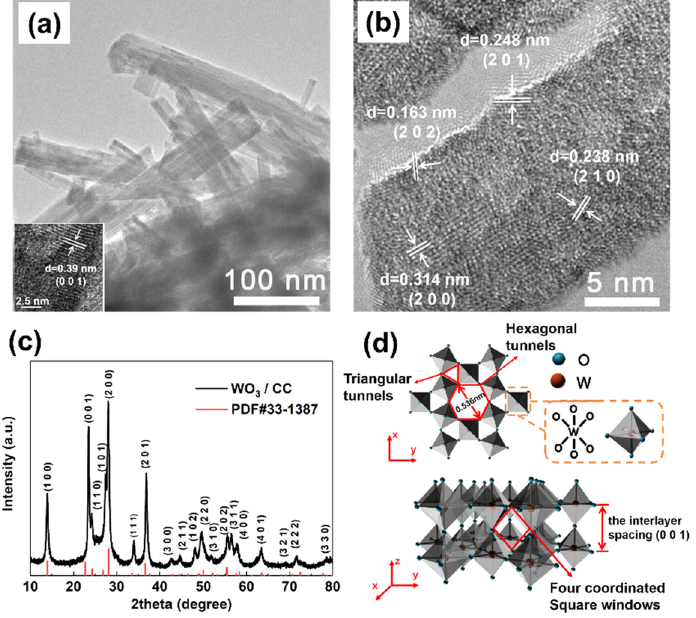
Figure 3. ( a , b ) TEM images of WO 3 ; ( c ) XRD pattern of WO 3 /CC; and ( d ) the schematic crystal structure of hexagonal WO 3 .